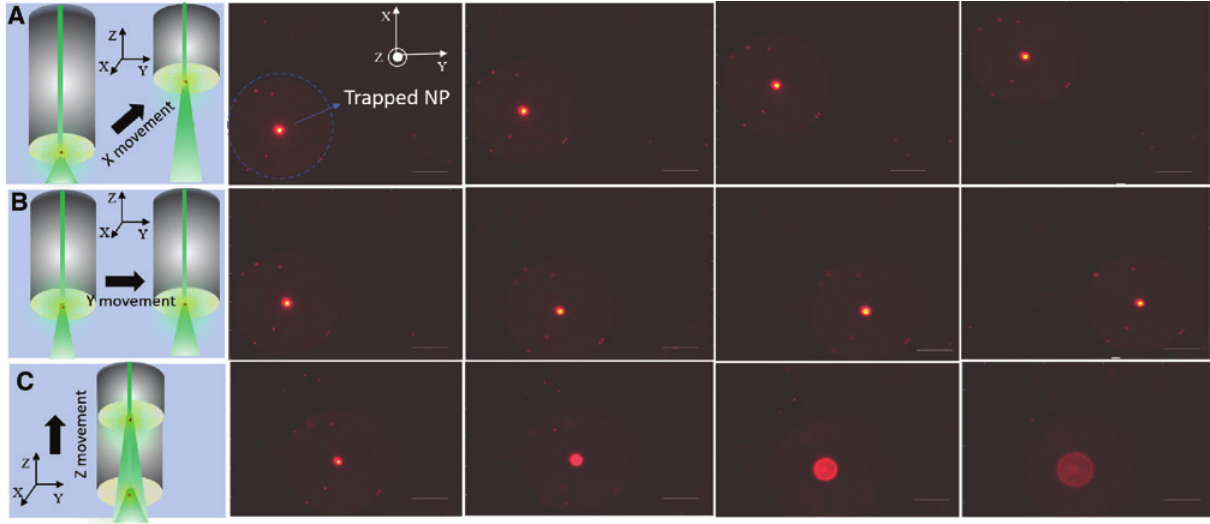
Figure 2: Three-dimensional manipulation of a single 200 nm fluorescent polystyrene nanoparticle in the (A) X direction, (B) Y direction, and (C) Z direction. Small, faint, stationary bright spots on the fiber surface correspond to some of the nanoparticles stuck at the cladding of the optical fiber tip. The scale bar for the figure is 50 μ